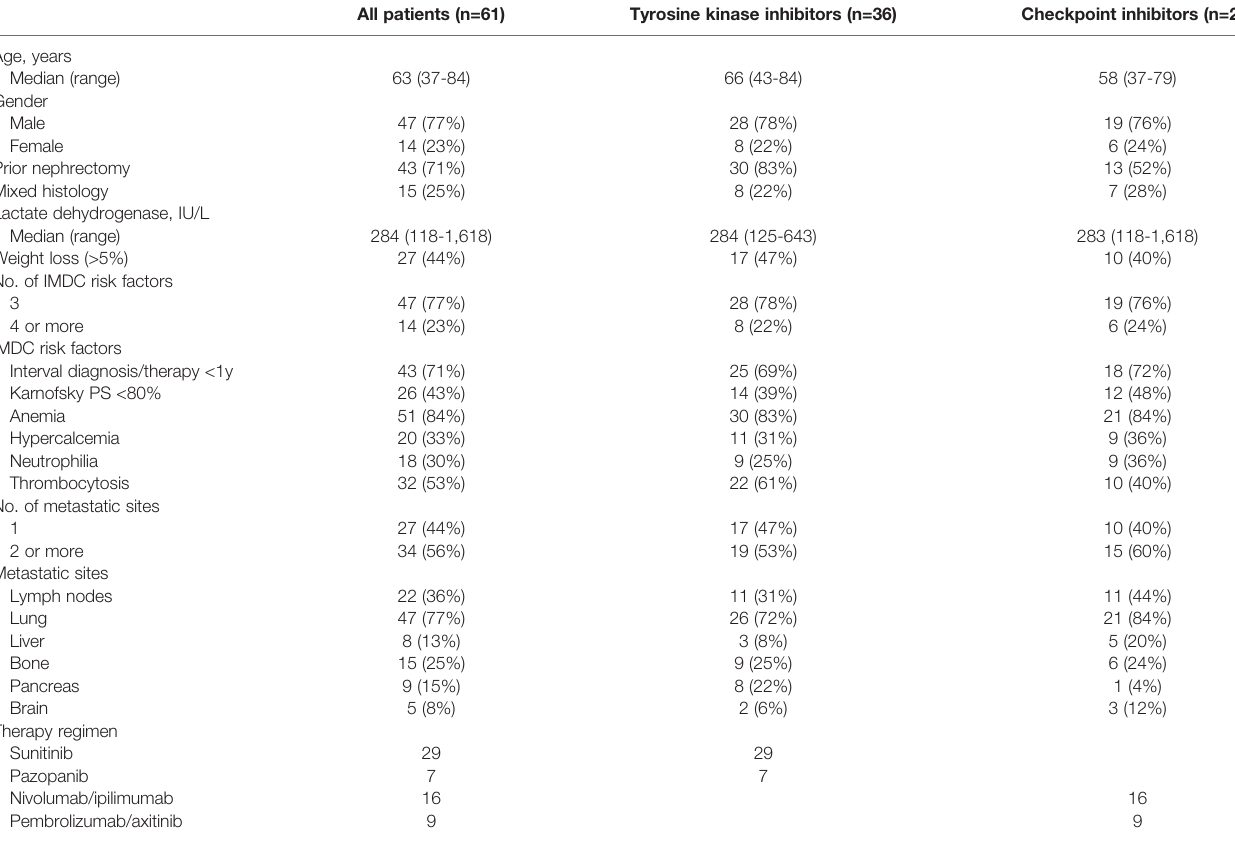
TABLE 1 | Patient characteristics of patients with poor risk, metastatic, clear cell renal cell carcinoma.